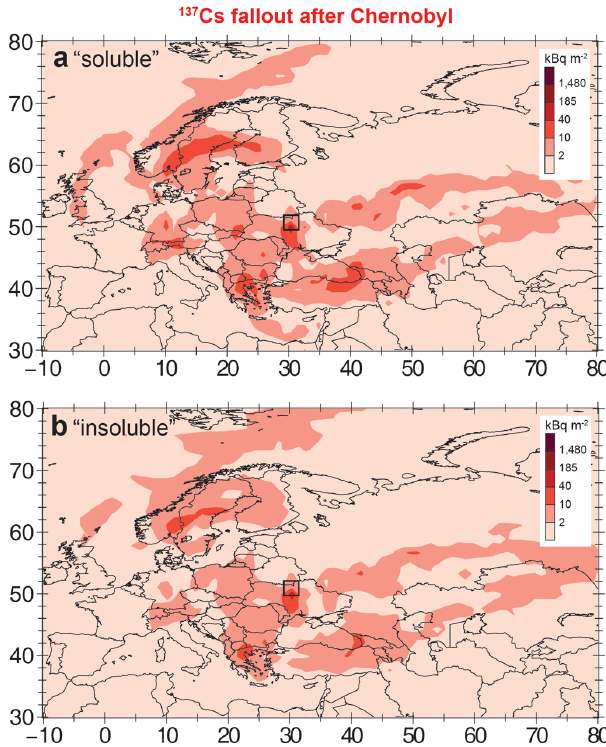
Fig. 1. Model calculated fallout of 137 Cs after the Chernobyl acci- dent, assuming a soluble particle tracer (a) and an insoluble one (b) . The location of Chernobyl is indicated by the black square. The colour scale is the same as in Peplow (2006); see http://www.nature.